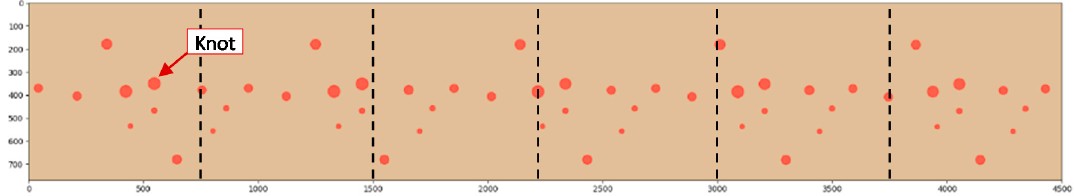
( b ) Figure 5. ( a ) Visual representation of log 1; ( b ) visual representation of log 2.